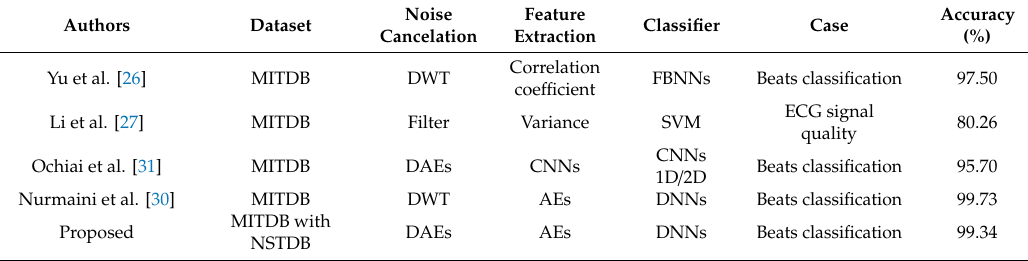
Table 8. The benchmark of the proposed model with another DL structure.